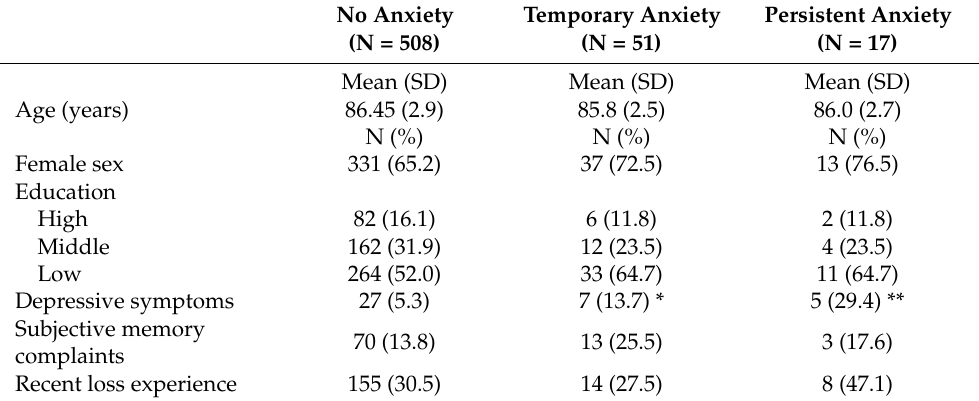
Table 5. Sample characteristics according to the course of anxiety from follow-up wave 5 to